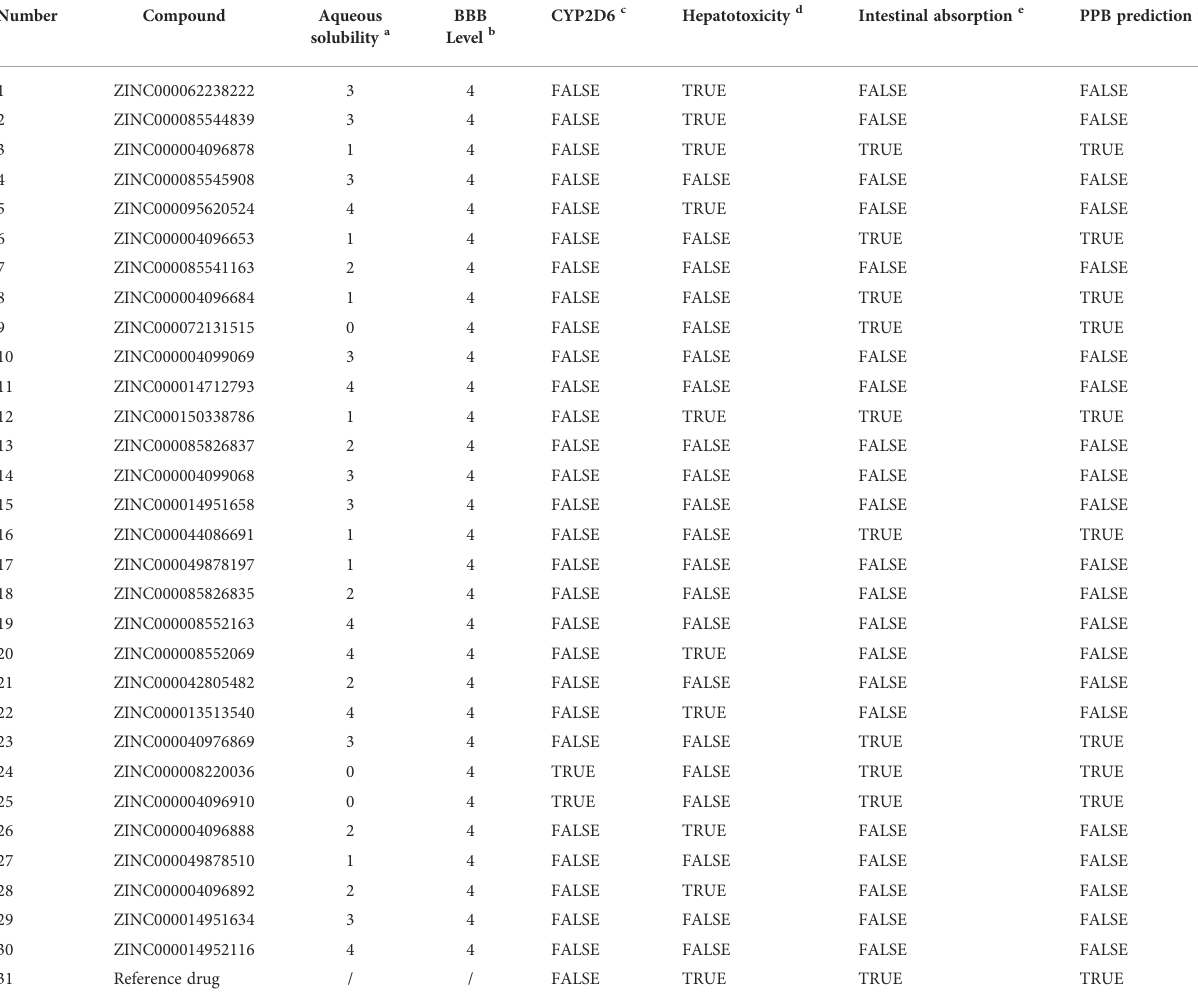
TABLE 3 Pharmacological properties of the top 30 materials based on ADME (Absorption, Distribution, Metabolism, and Excretion). Number Compound